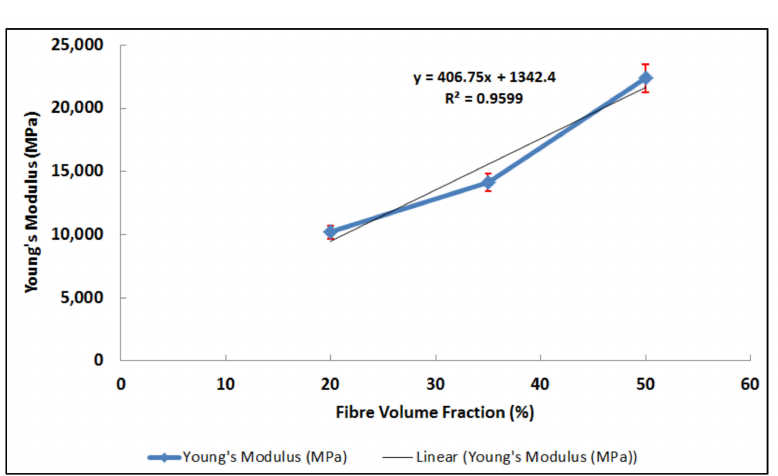
Figure 4. Young’s Modulus for polyester specimens reinforced with 20%, 35%, and 50% fibre volume